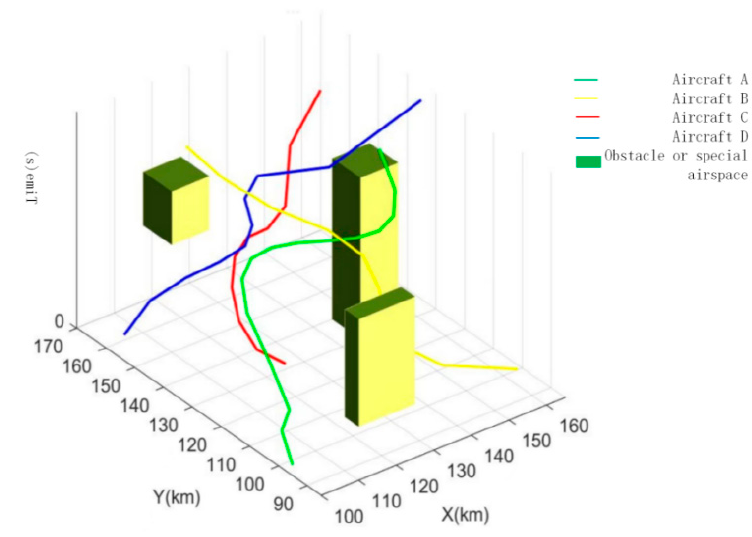
Figure 15. Schematic of 3D track planning results for four aircrafts after smoothing.